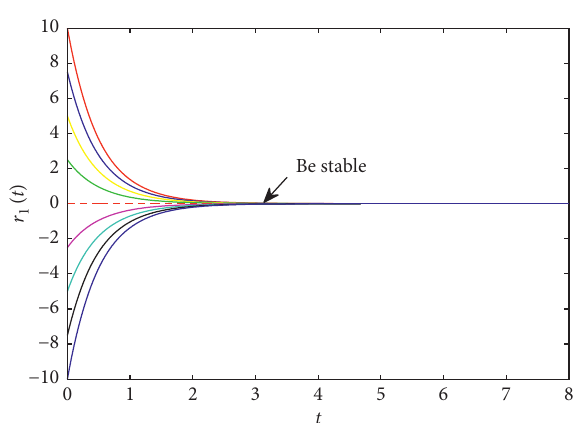
Figure 3: The EGS of r